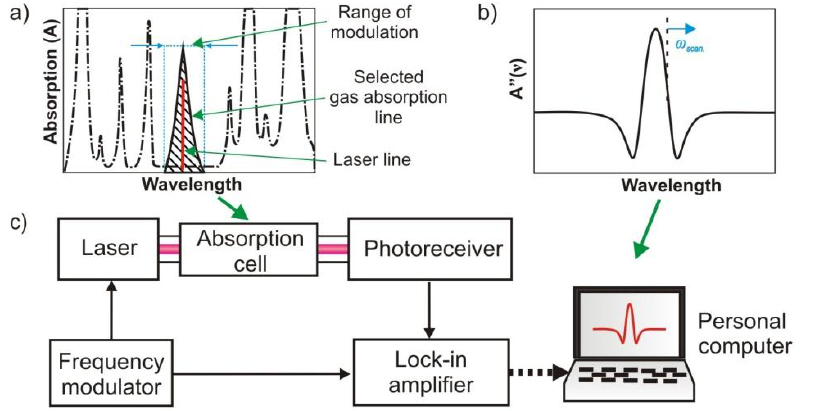
Figure 12. Operation idea of TLAS: spectrum scanning ( a ); the result of measurement ( b ); and experimental scheme ( c